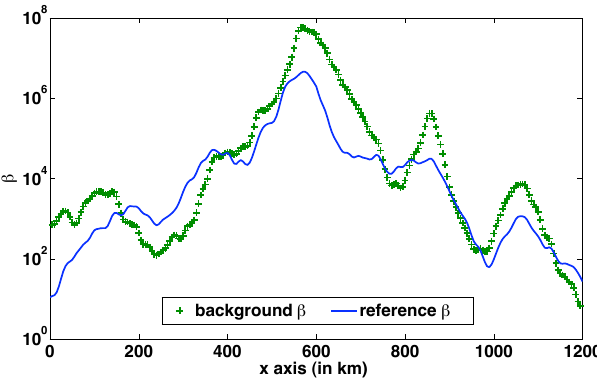
Fig. 3. Basal sliding parameter β(x) as a function of the ice sheet extent x , for the reference state (solid blue) and the background (green crosses), in log scale.